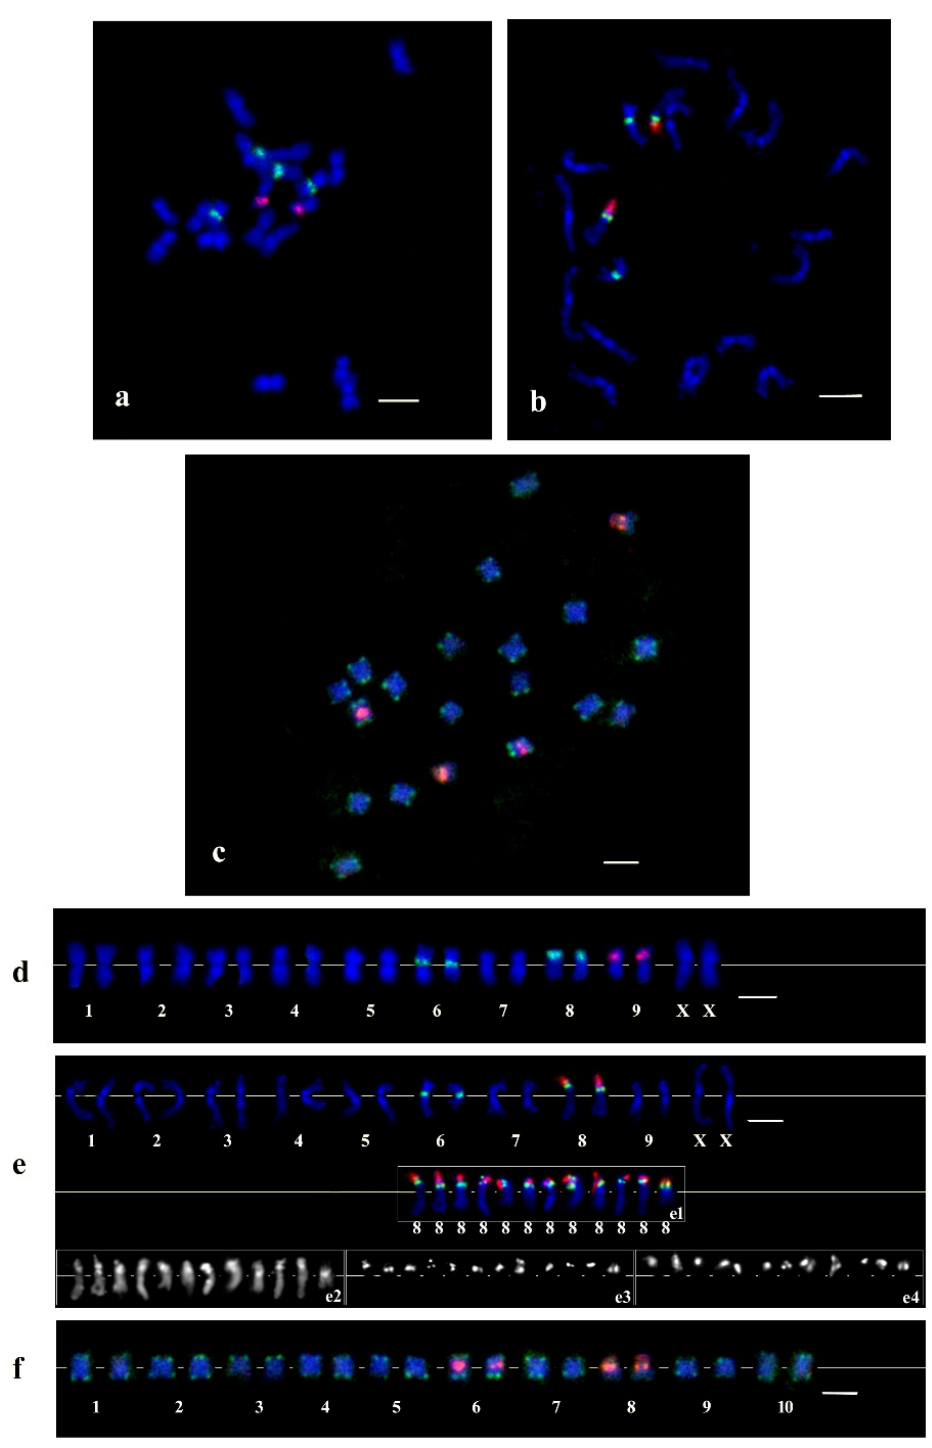
Figure 3. The results of FISH experiments and karyotyping with the CS-237 probe on C. sativa chromosomes: ( a , d ) green—CS237 probe, pink—5S rDNA probe; ( b , e ) green—CS237 probe, pink—45S rDNA; ( c , f ) green—CS-1 probe, pink—CS237 probe. Single channels: ( e2 ) DAPI, ( e3 ) CS237, ( e4 ) 45S rDNA, and ( e1 ) merged. Bar equals 5 μ m.